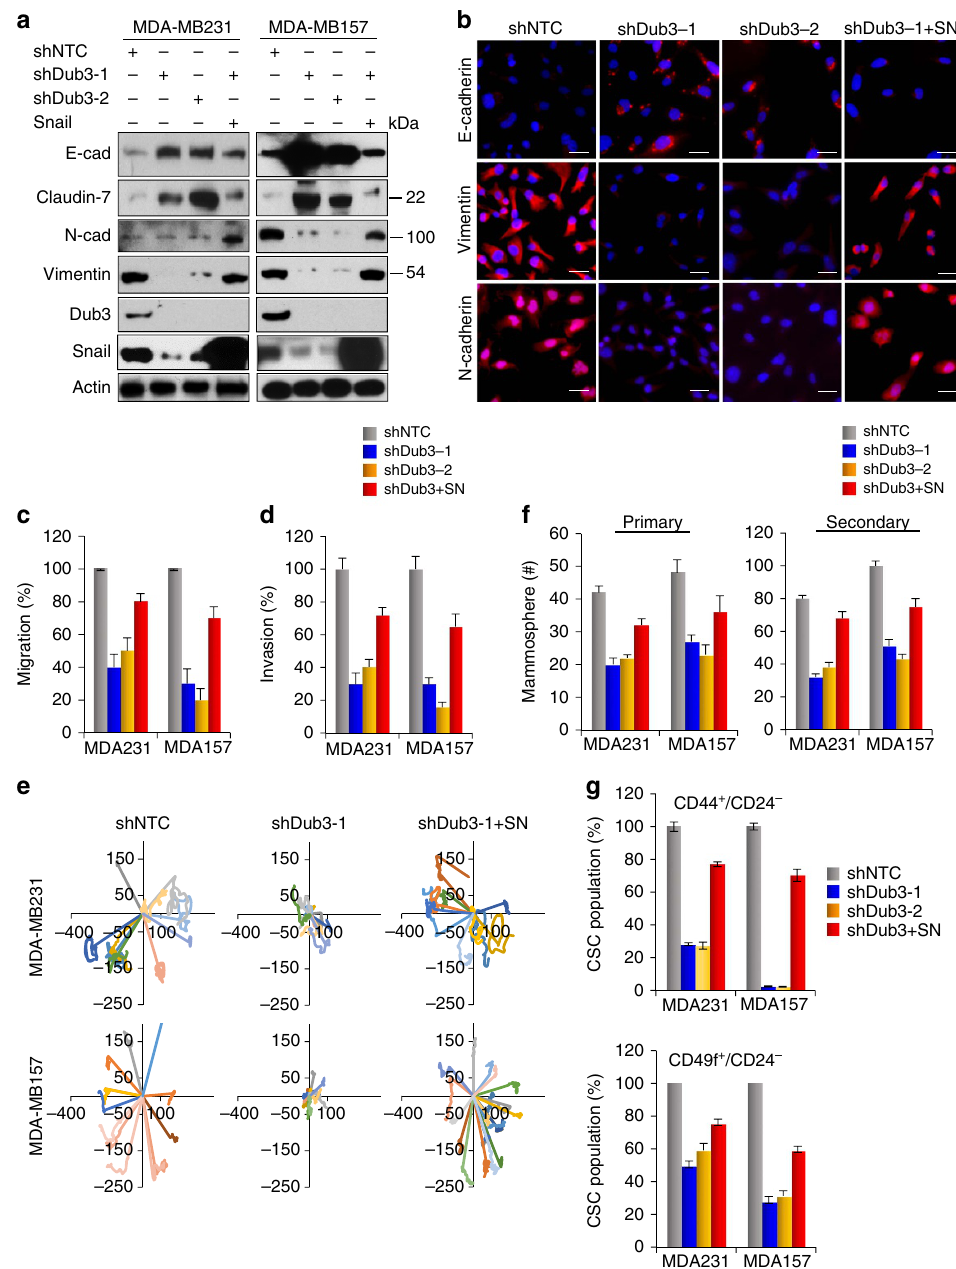
Figure 5 | Knockdown of Dub3 inhibits migration, invasion and CSC-like characteristics in BLBC cells by downregulation of Snail1. ( a ) Dub3 was knocked down by two different shRNA in MDA-MB231 and MDA-MB157 cells. Rescued Snail1 expression in these Dub3-knockdown clones were also performed. The expression of E-cadherin, Claudin-7, N-Cadherin, Vimentin, Dub3, and Snail1 was analysed by western blot. ( b ) IF images of EMTmarkers in MDA-MB231 cell lines described in ( a ). Scale bars, 20 m m. ( c ) Graphic representation of cell motility described in a analysed by a wound healing assay. Data are the percentage of migrating cells as the mean ± s.e.m. of three separate experiments. ( d ) Graphic representation of cell invasion described in a . Data are the percentage of vector control values (mean ± s.e.m. in three separate experiments in duplicates). ( e ) Cell trajectories of randomly selected cells described in a ; each line indicates an individual cell’s migration. ( f ) Graphic representation of primary and secondary tumorsphere-formation from cells described in a and are the mean ± s.d. from three independent experiments (left panel). ( g ) Graphic representation of the CD44 high /CD24 low (top) and CD49f high /CD24 low population from cells described in a was examined by FACS analysis and are the mean ± s.e.m. from three independent